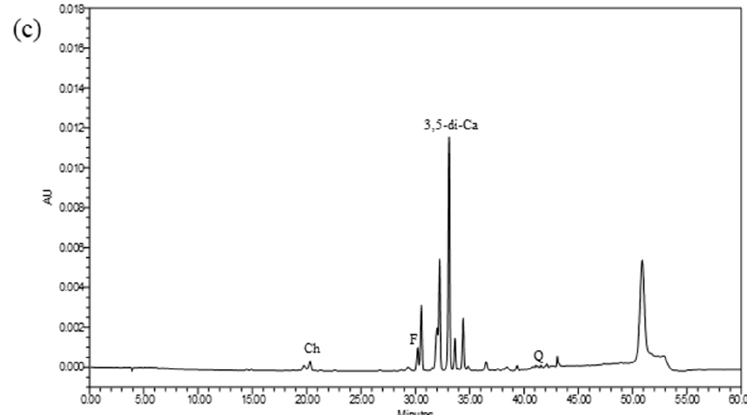
Figure 1. Chromatograms from HPLC analysis of IPC70 and IPC95 extracts. Chlorogenic acid (Ch), ferulic acid (F), 3,5-di-caffeoylquinic acid (3,5-di-Ca), and quercetin (Q) were detected at 360 nm. ( a ) standards, ( b ) IPC70 extract, and ( c ) IPC95 extract.